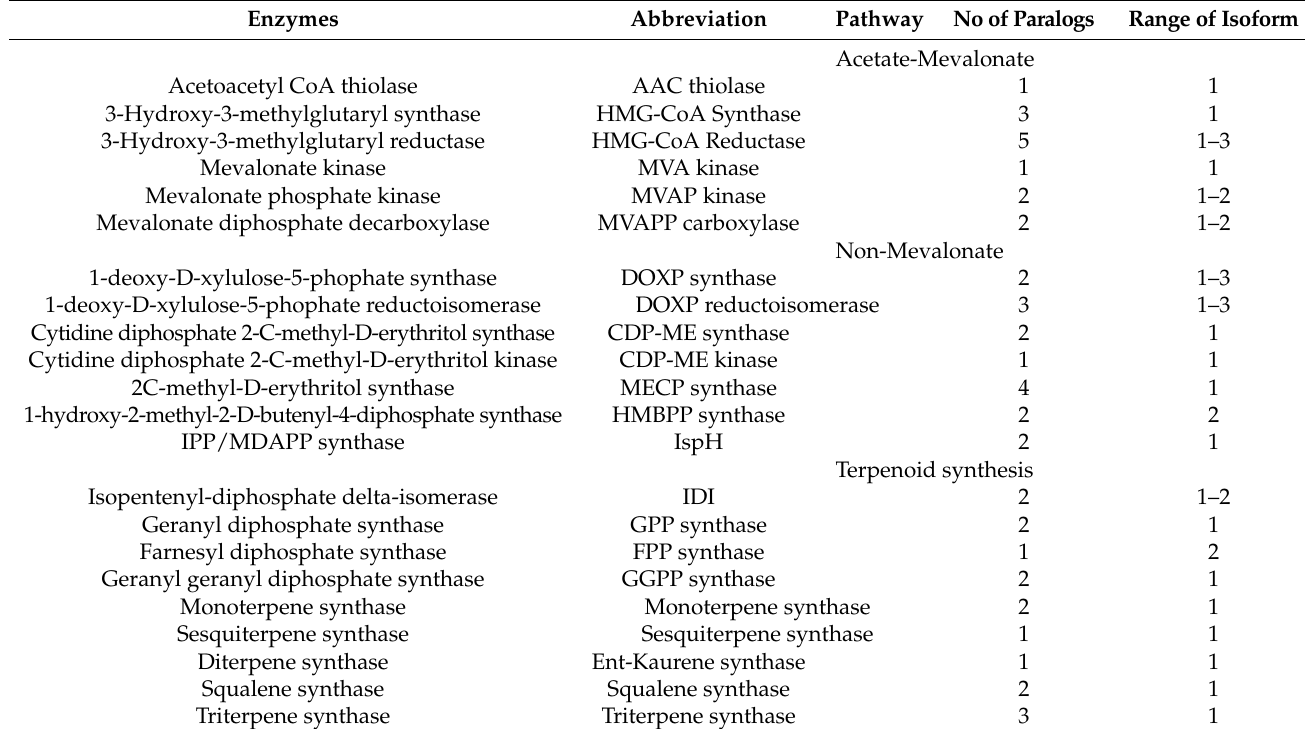
Table 5. Enzymes involved in the biosynthesis of terpenoids, isopentyl diphosphate, and dimethylal- lyl